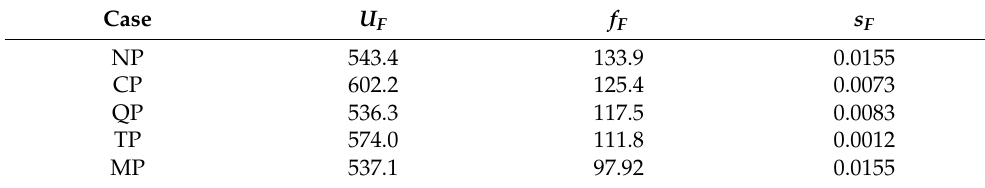
Table 2. Comparison of flutter characteristics of the panel under different cases.